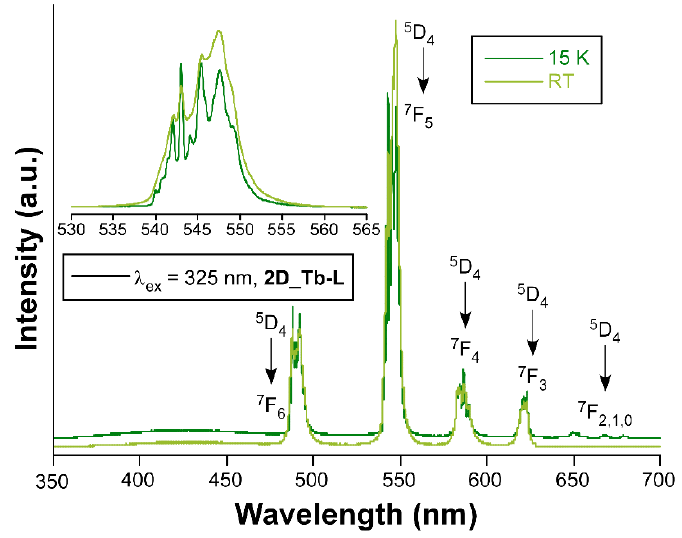
Figure 8. Emission spectra of compounds 2D_Tb-L recorded at RT and 15K.